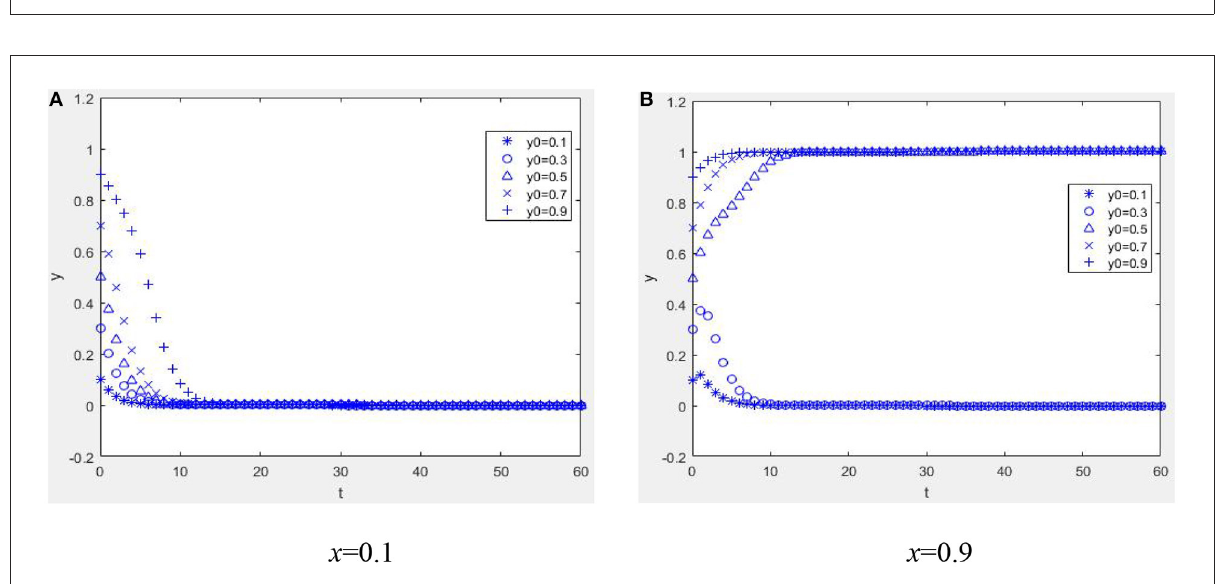
FIGURE4 Dynamic evolution diagram under Case 3. (A) x = 0.1 and (B) x = 0.9.